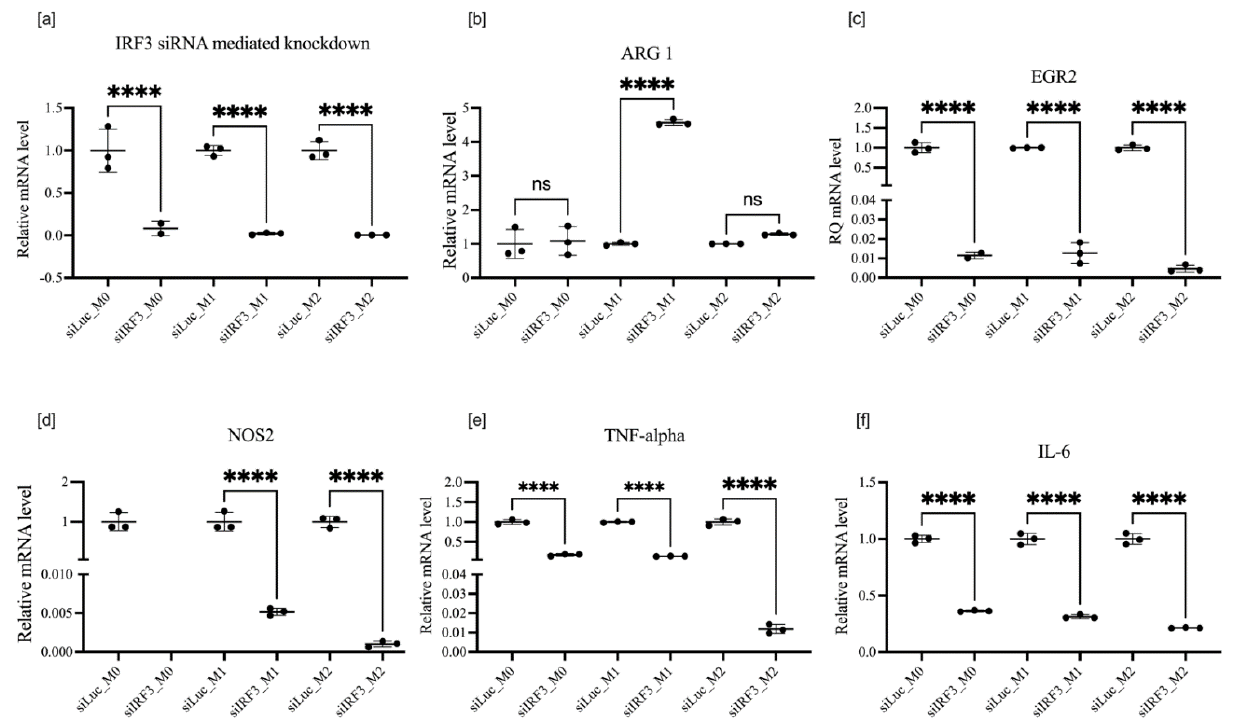
( f ) after ( f ) after 𝛼𝛼 𝛼𝛼